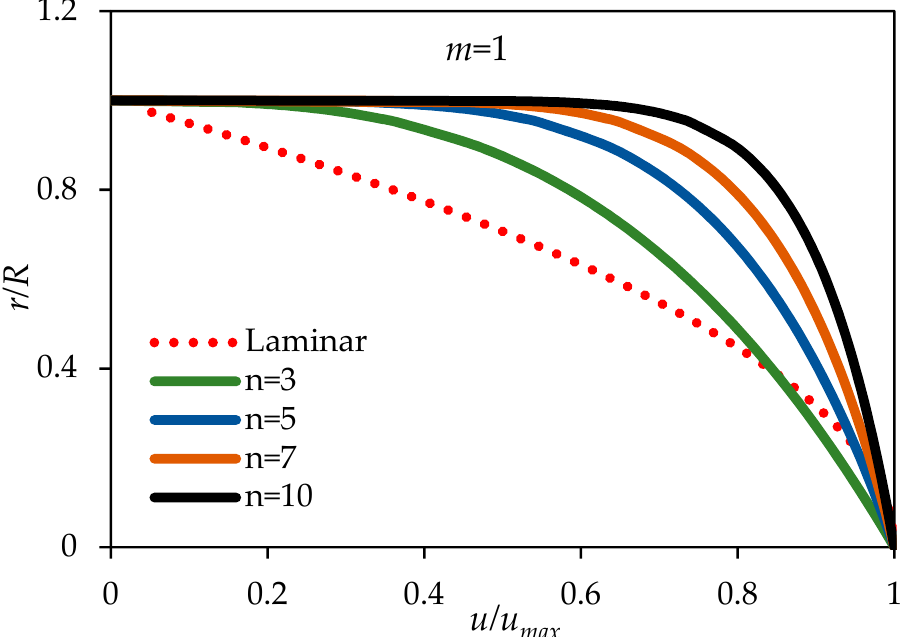
Figure 4. Normalized velocity profile ( u/u max ) variations along the pipe normalized radius when m = 1.